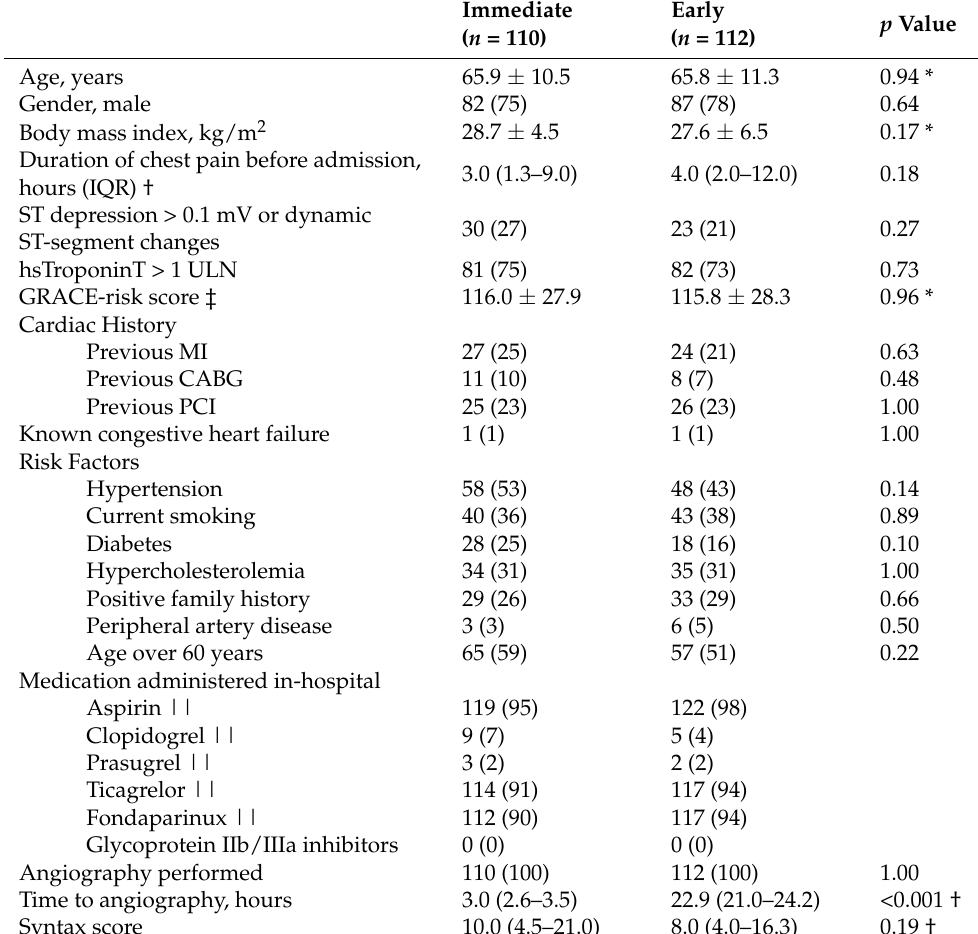
Table 1. Baseline and procedural